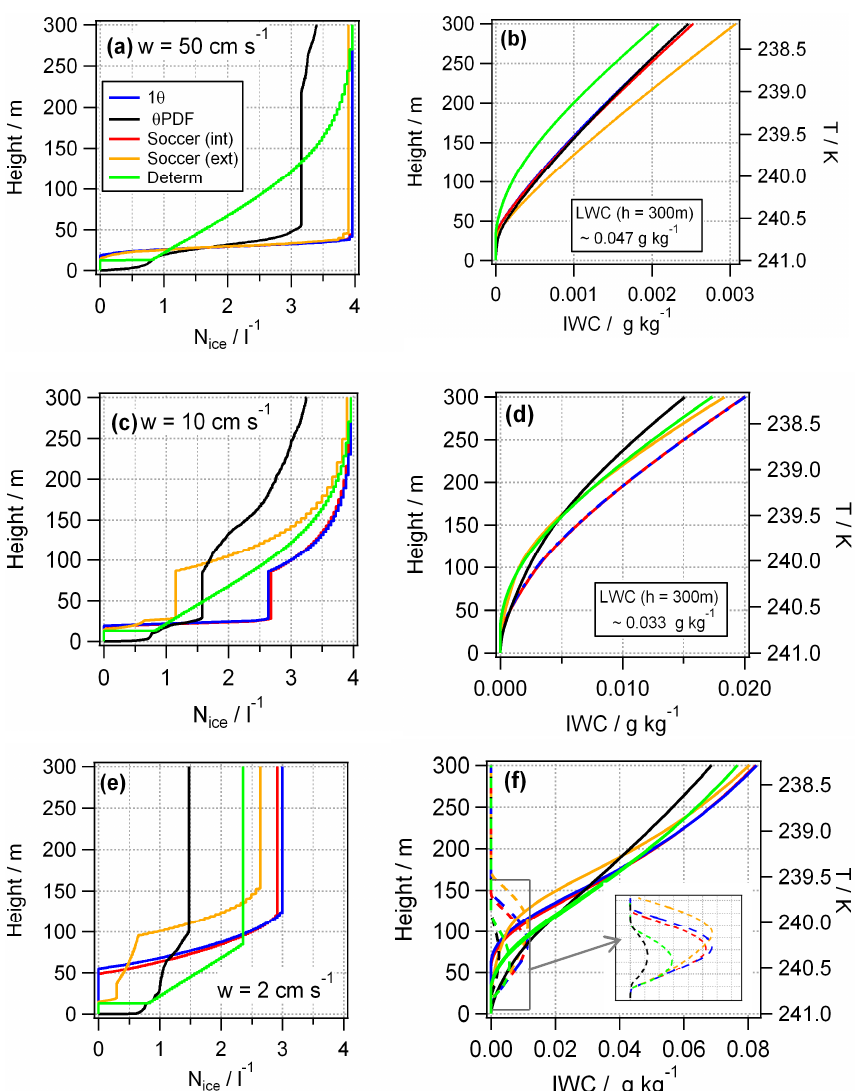
Figure 4. Parcel model results using the five schemes as described in Figure 1 and Table 1. (a, c, e) Evolution of N ice for an IN population with N IN = 4l − 1 for three different updraft velocities ( w = 50cms − 1 , 10cms − 1 , 2cms − 1 ) and a cloud depth of 300m (238.2K <T < 241K). (b, d, f) Ice water content IWC for the five nucleation schemes. The LWC in (b, d) is approximately the same for all schemes since the liquid phase is not significantly impacted by the ice phase. The dashed lines in (f) denote the liquid water content (LWC). The inset shows a zoom of the grey box. The stepwise behavior in the increase of N ice for the stochastic schemes is due to the probability steps we assume in order to avoid a high number of ice particle classes in the simulations (Sect.